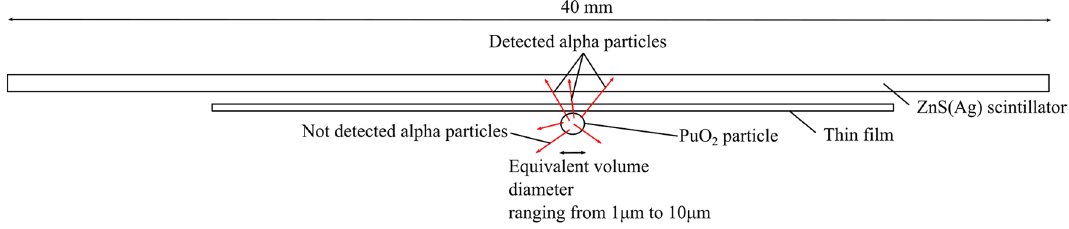
Figure 15. Geometry of the Monte Carlo simulation setup, which is the same as that of the measurement. The equivalent volume of the PuO 2 particle is varied from 1 to 10